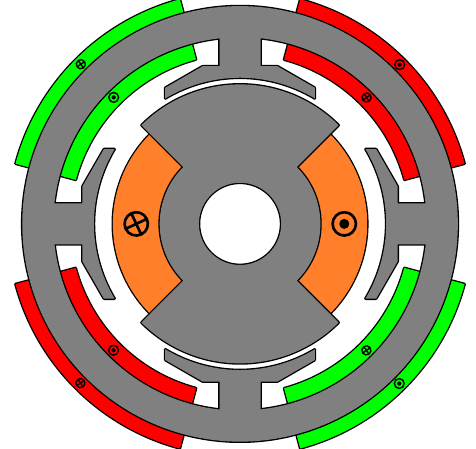
Figure 16. Toroidal winding slotted resolver with four